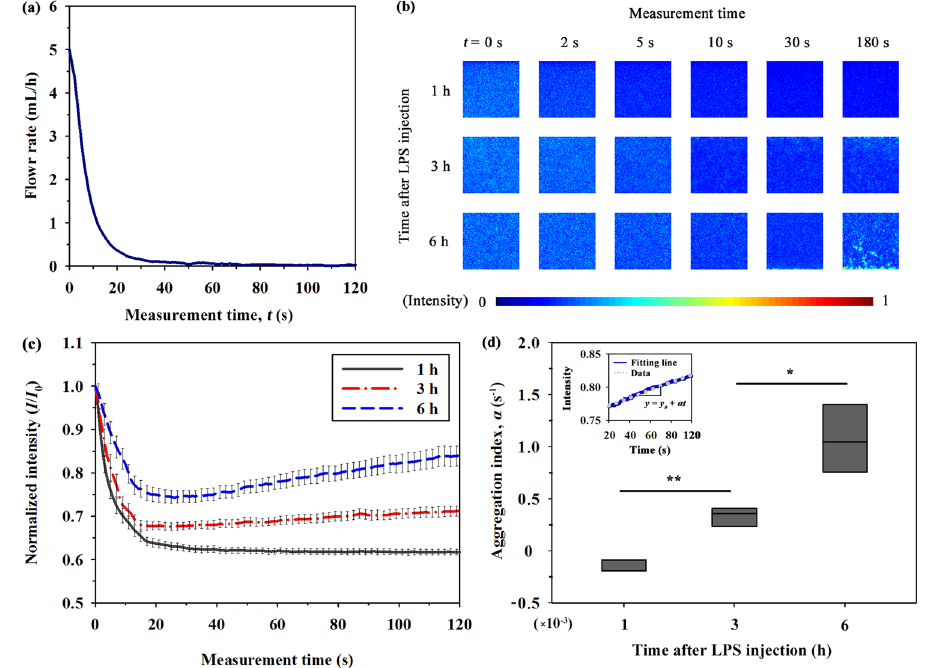
Figure 3. Variation in RBC aggregation measured by analyzing image intensity. ( a ) Temporal variation in flow rate of blood samples estimated by micro-PIV technique. ( b ) A series of speckle images for blood samples after the lapse of 1, 3, and 6 h from LPS injection with respect to measurement time. The size of each image is 128 × 128 pixels, corresponding to 0.64 × 0.64 mm 2 in the physical dimension. ( c ) Temporal variations in the normalized light intensity ( I / I 0 ) of blood samples after 1, 3, and 6 h from LPS injection at the center of the channel. ( d ) Comparison of aggregation index ( α ) according to the measurement time after LPS injection. Light intensities of blood samples at 6 h after LPS injection, and the corresponding fitting curves are inserted. ( * p < 0.005 and ** p < 0.001: significant difference between